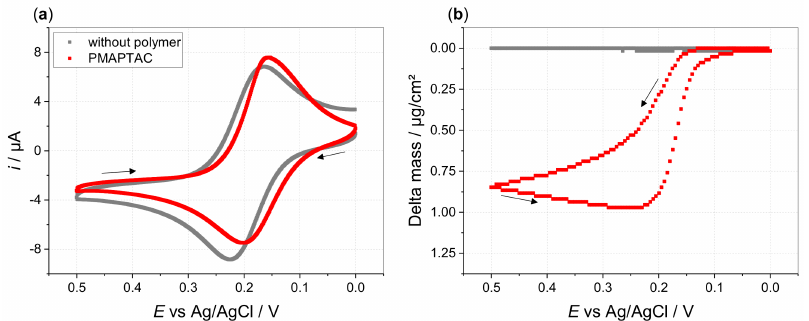
Figure 5. Electrochemical quartz crystal microbalance measurements during a voltage sweep (potential scanned from 0 to 0.5 to 0 V vs. Ag/AgCl with ν = 5 mV/s) applied to 0.1 M KCl, 0.13 mM HCF(II) in absence (grey) and presence of 0.52 mM PMAPTAC (red), ( a ) cyclic voltammograms and ( b ) delta mass vs.